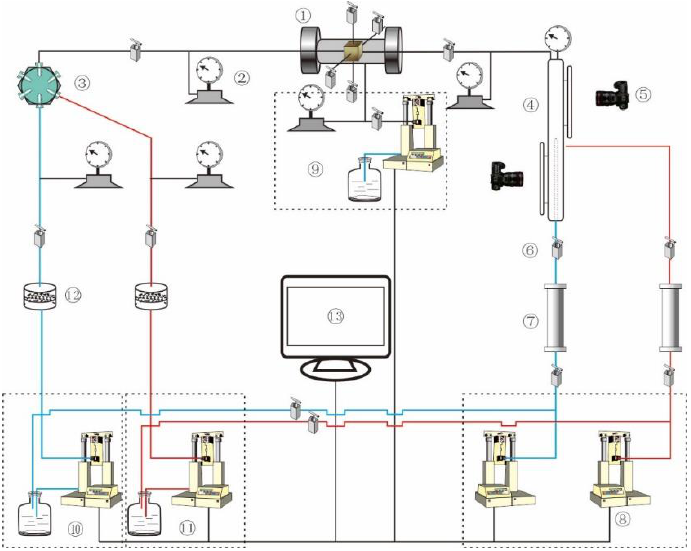
Figure 2. Schematic representation of the experimental apparatus of the anisotropic relative perme- ability measurement.